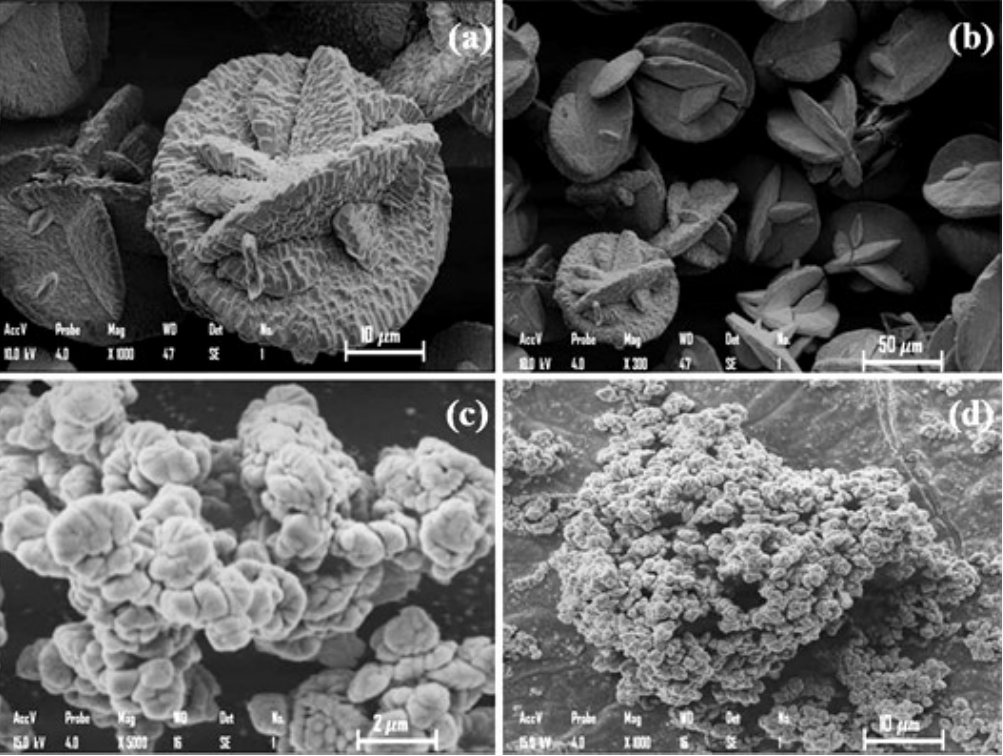
seeds; (c) and (d) S seeds. 1 2